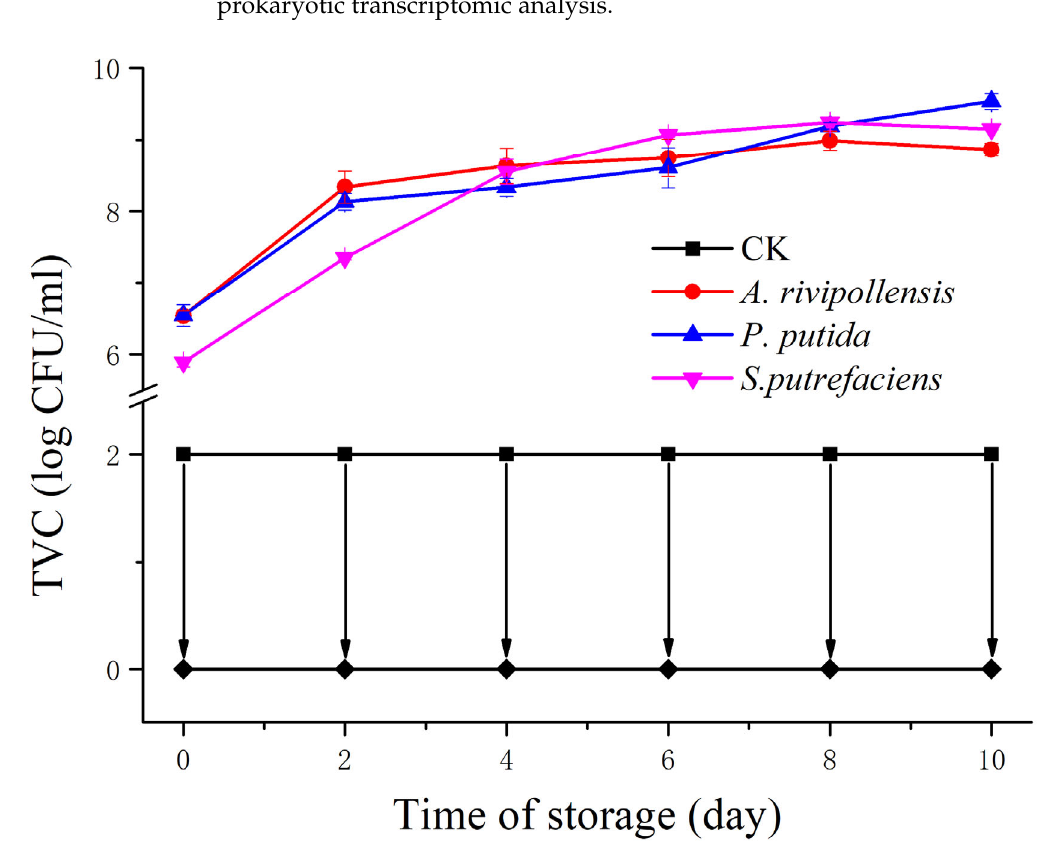
Figure 1. Changes in the total viable counts (TVC) of grass carp juice inoculated with different spoil ‐ age bacteria during 4 °C storage. CK: Not inoculated. spoilage bacteria during 4 ◦ C storage. CK: Not